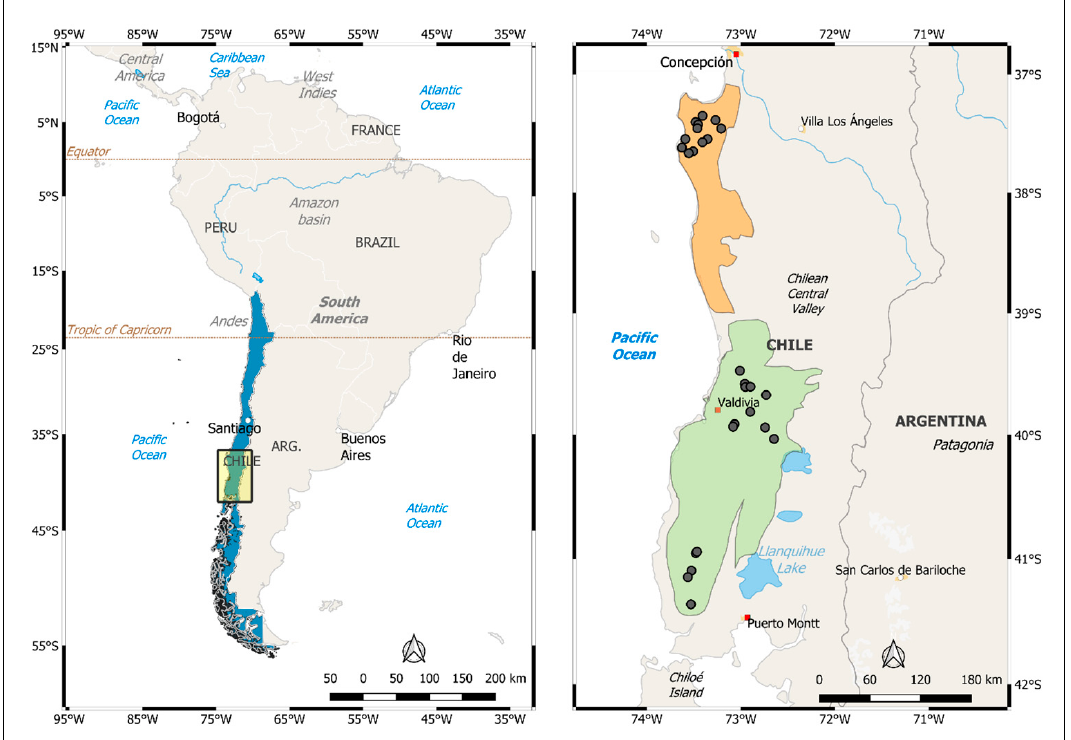
Figure 1. Map of E. nitens × E. globulus trial distribution. Left: global location of the trials, with the country region depicted in blue and the study location in yellow. Right: detailed location of the trials per breeding zone. Represented in orange is the Arauco zone, and in green the Valdivia zone. Each black dot represents the location of a field test.